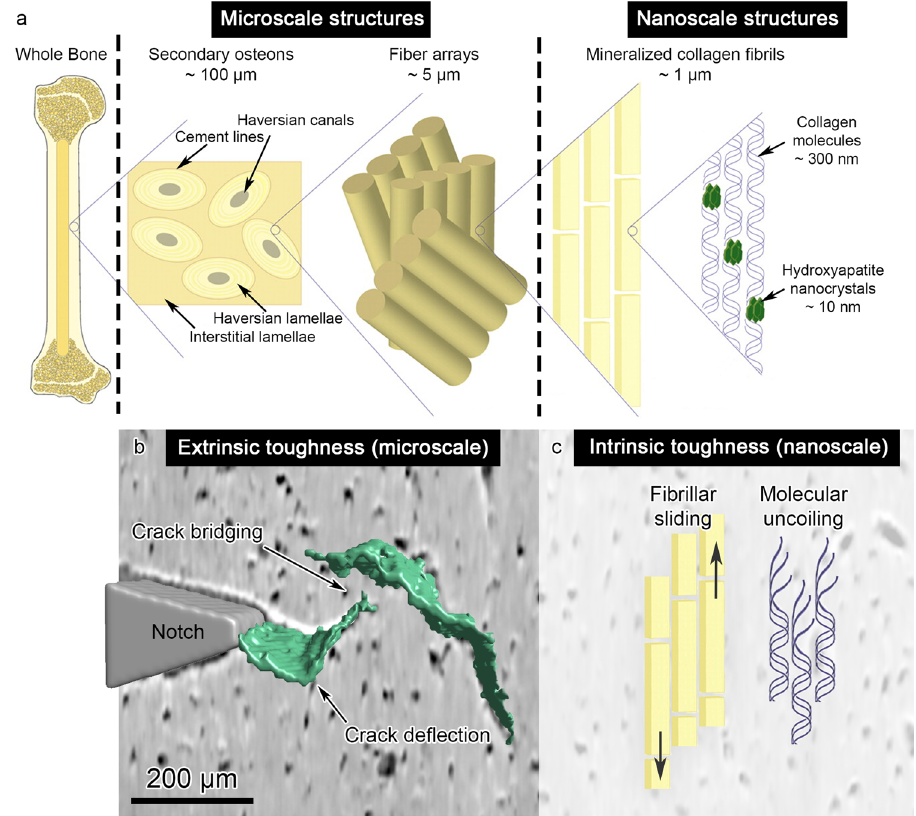
Fig. 1 Overview of bone ’ s hierarchical structure and bone ’ s toughening mechanisms. a Bone ’ s hierarchical structure shows features ranging from the macroscale to the nanoscale. b Bone ’ s extrinsic toughening mechanisms are illustrated using a 3D SR μ CT image acquired during a toughness test. Extrinsic toughness mechanisms occur in the wake of the crack (green) and are attributed to microscale features in the bone. c Bone ’ s intrinsic toughening mechanisms, which are attributed to nanoscale features, occur ahead of the crack and are primarily attributed to aspects of collagen structure and composition. Fibrillar sliding and uncoiling of the collagen structure are mechanisms that contribute to intrinsic toughness in bone. There are additional mechanisms that impact bone ’ s intrinsic toughness, such as collagen cross-linking and sacri fi cial bonds. Collagen cross-linking at the nanoscale is known to in fl uence mechanical properties 34 . Sacri fi cial bonds form between collagen fi brils creating a glue-like layer that contributes to bone ’ s resistance to fracture 32,36 . Figure adapted from Zimmermann et al. 115 , with permission from The Proc. Natl. Acad. Sci.